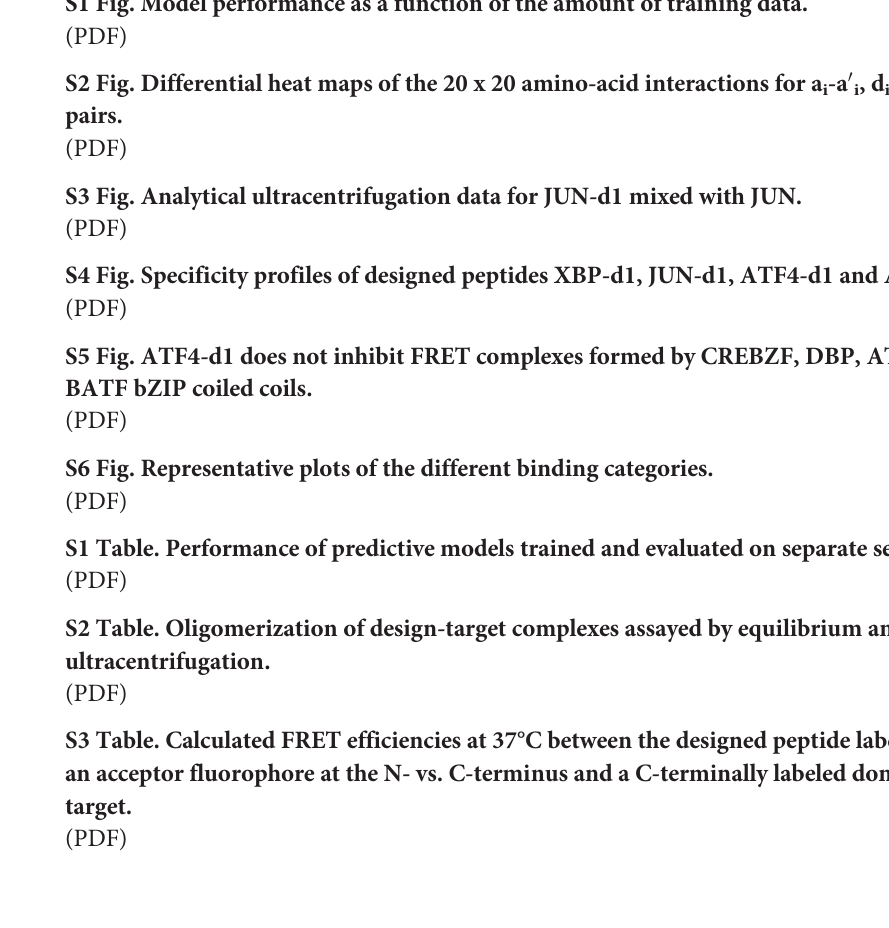
-a 0 , d -d 0 , g -e 0 i i i i i i+1